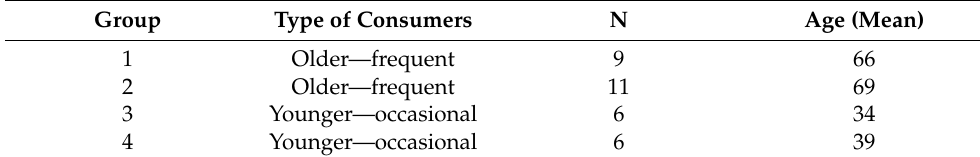
Table 4. Characteristics of the participants were divided into 4 focus groups ( n = 32).